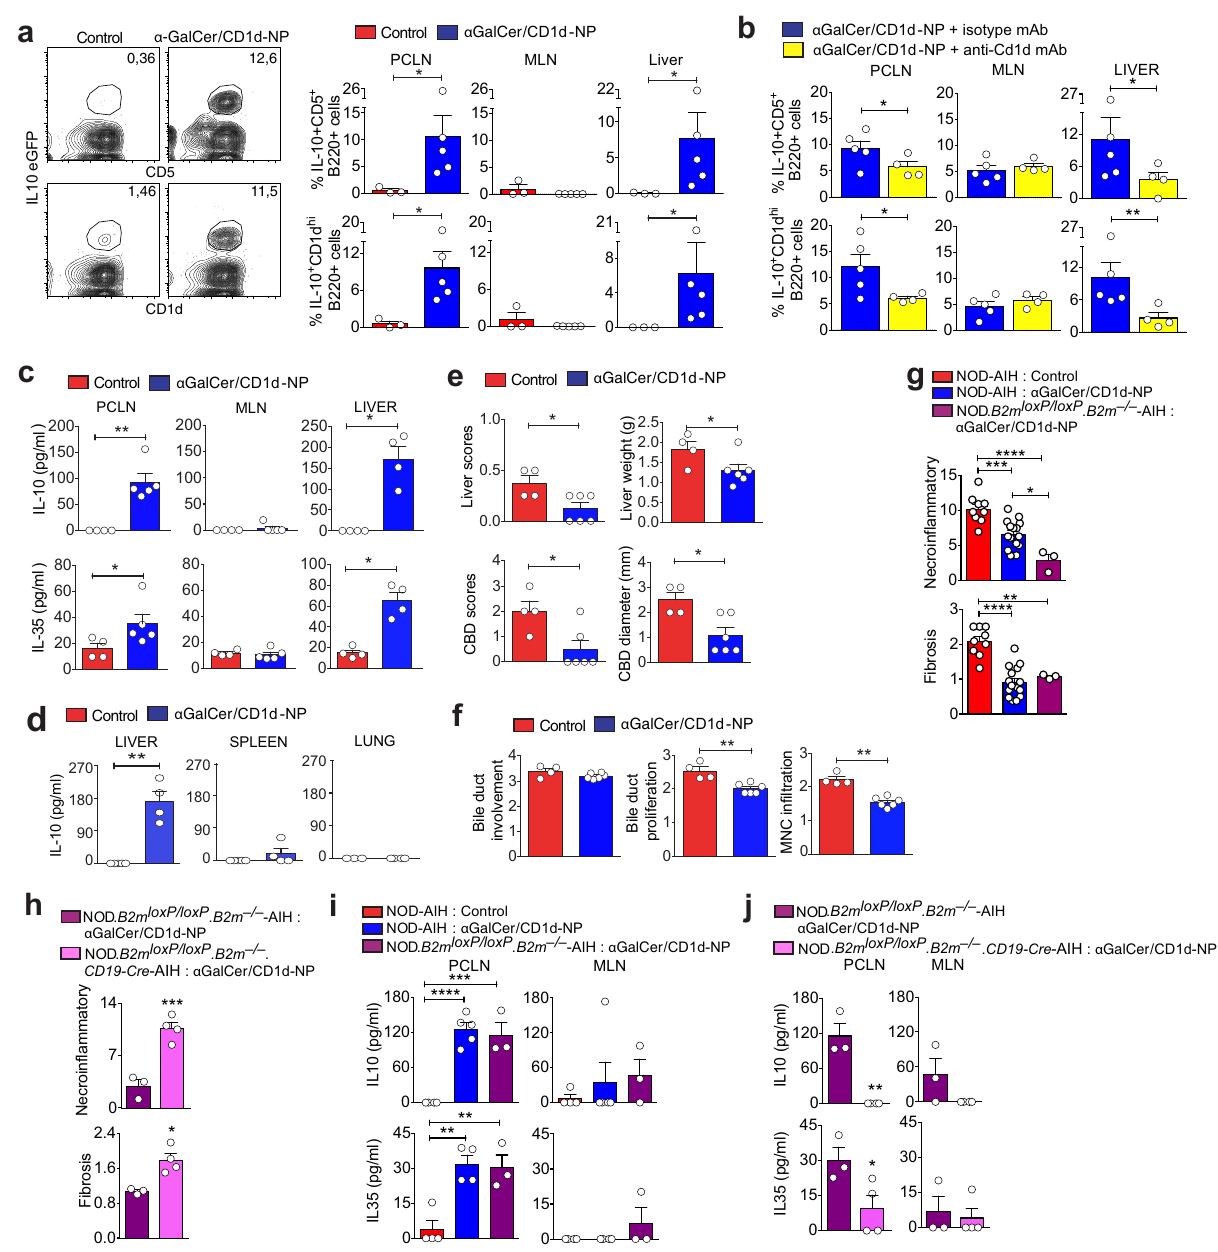
Fig. 7 Local and proximal LiNKTR1-driven Breg cell formation via cognate interactions. a , b Conversion of adoptively transferred eGFP – B cells